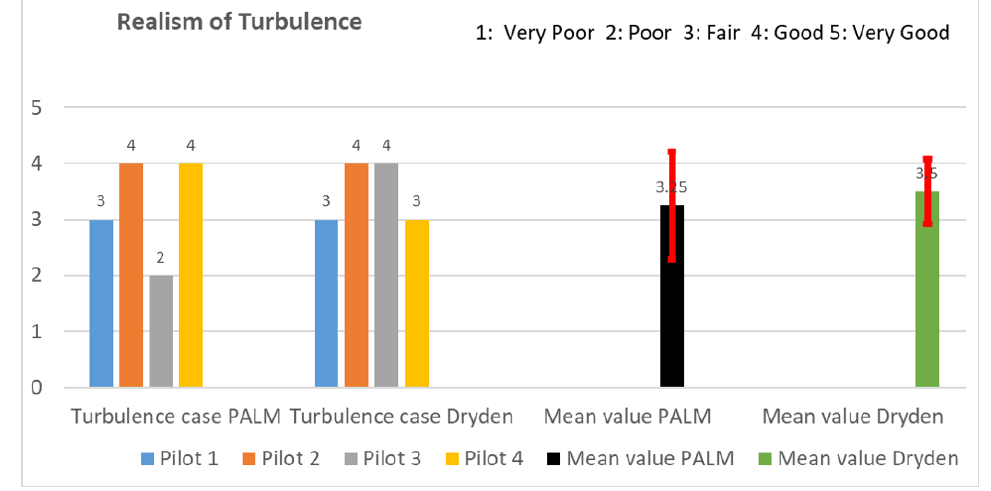
Figure A4. Realism of turbulence.